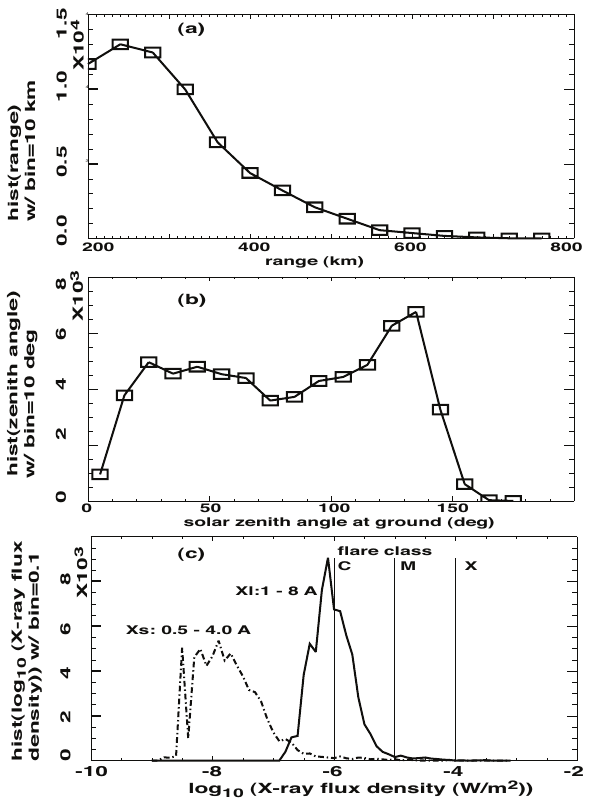
Fig. 3. Distributions of the 65000 height retrievals against three geophysical variables: (a) lightning-to-station range, (b) solar zenith angle, and (c) both short- and long-wave solar X-ray flux density. The X-ray data are 5-min-averaged SEM data from the GOES-10 satellite (see